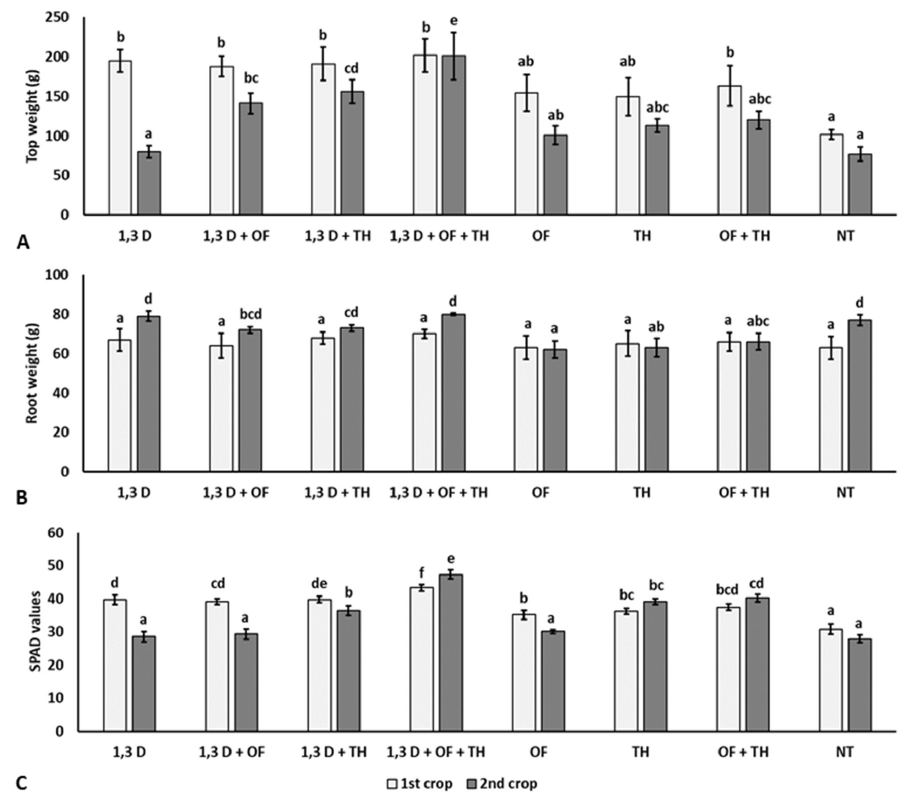
Figure 3. Effects of soil treatments with 1,3-dichloropropene (1,3-D), Trichoderma harzianum (TH) and an organic fertilizer (OF), either alone or in combination, on weight of aerial parts ( A ), roots ( B ) and chlorophyll content ( C ) of plants from the two tomato crops. NT = non-treated control. Bars show the average of n = 4 replicates of each treatment ± S.E. Within each tomato crop, bars marked by the same letters are not significantly different according to the least significant difference test ( p ≤ 0.05).